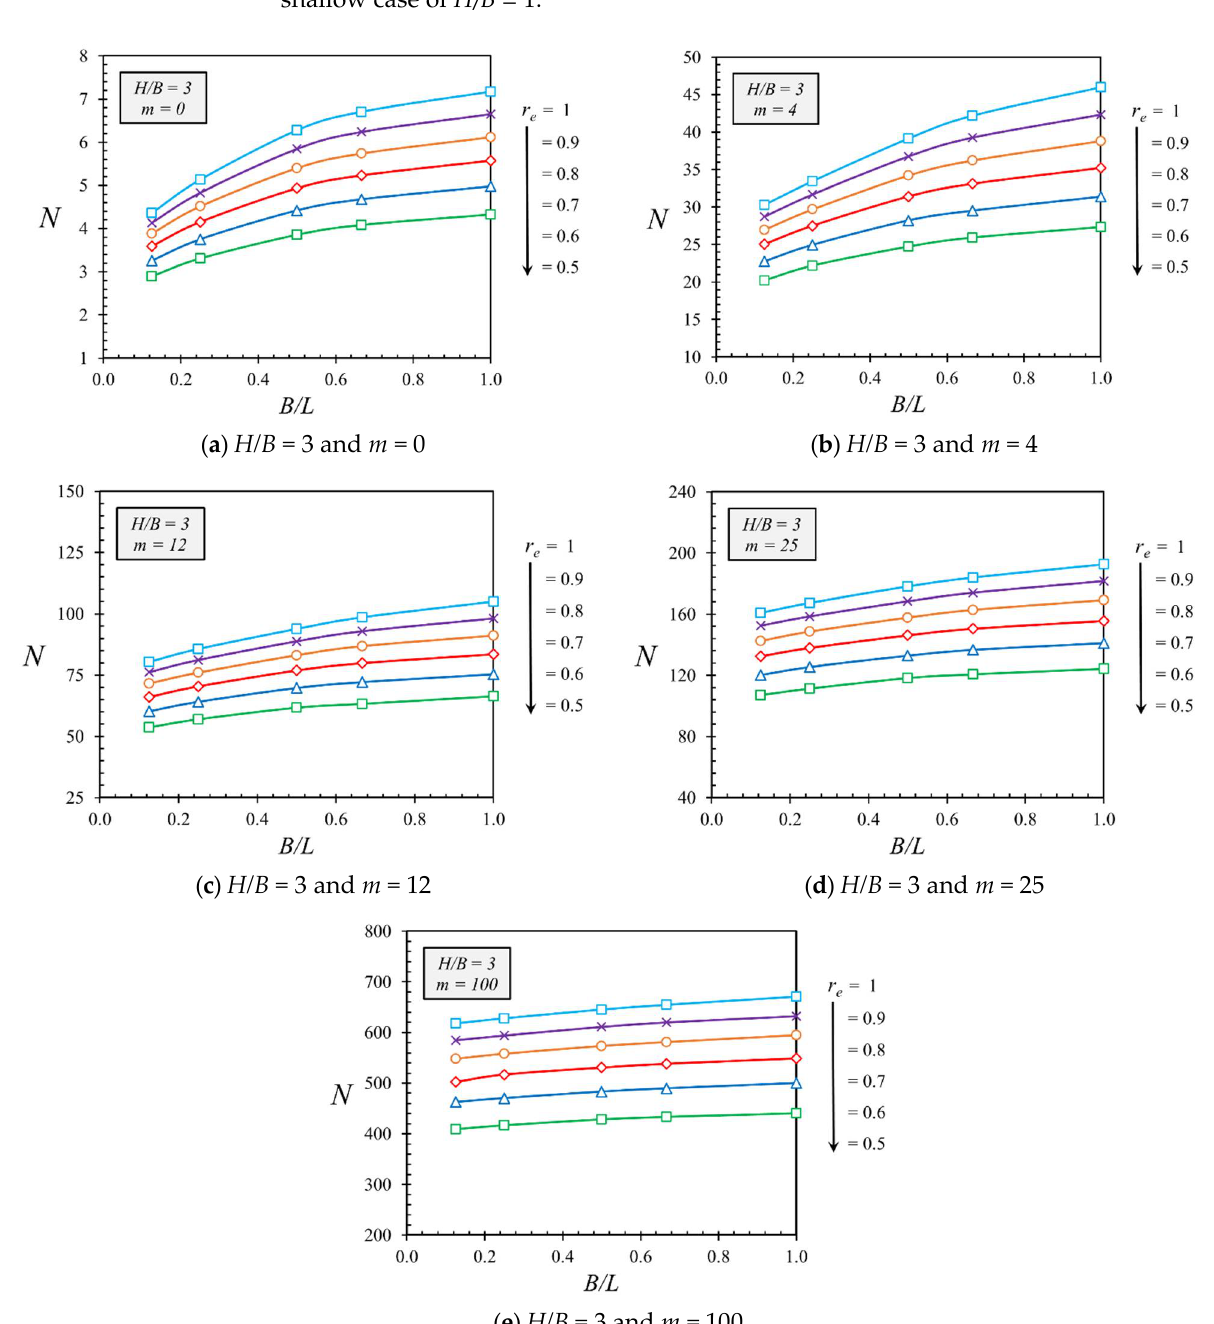
Figure 7. N vs. B/L for the various r e ( H / B = 3.0 and m = 0, 4, 12, 25, 100).